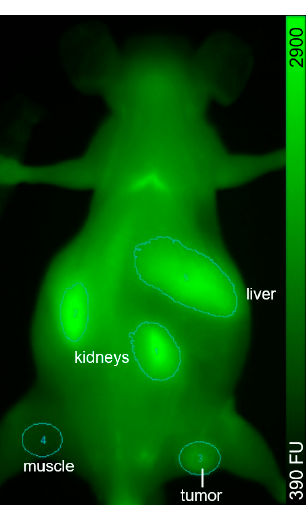
Figure A23. Regions of interest (ROIs) of organs during live imaging in vivo 48 h p.i. as example for AuNP-RGD-NIR-dye 8: ratio-to-muscle of kidneys 2.40 ± 0.12, tumor 1.47 ± 0.07, and liver 2.20 ± 0.11.